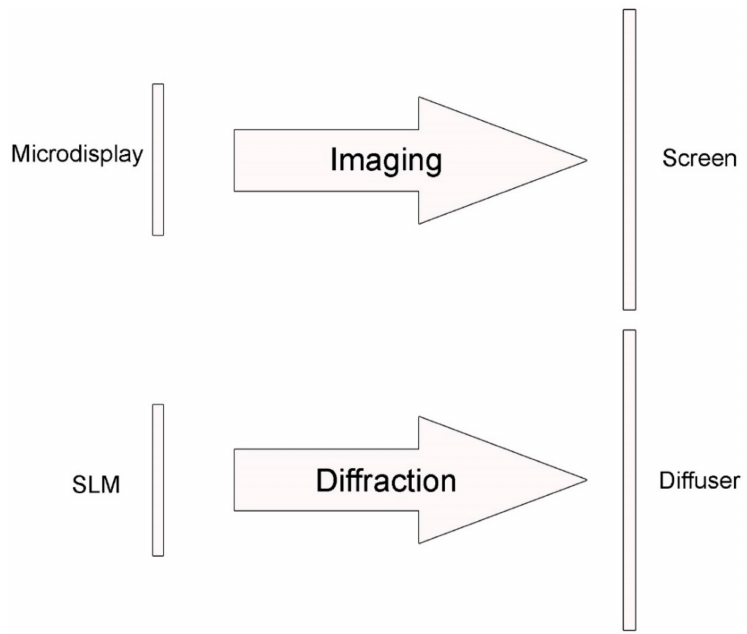
Figure 6. High performance, phase-only